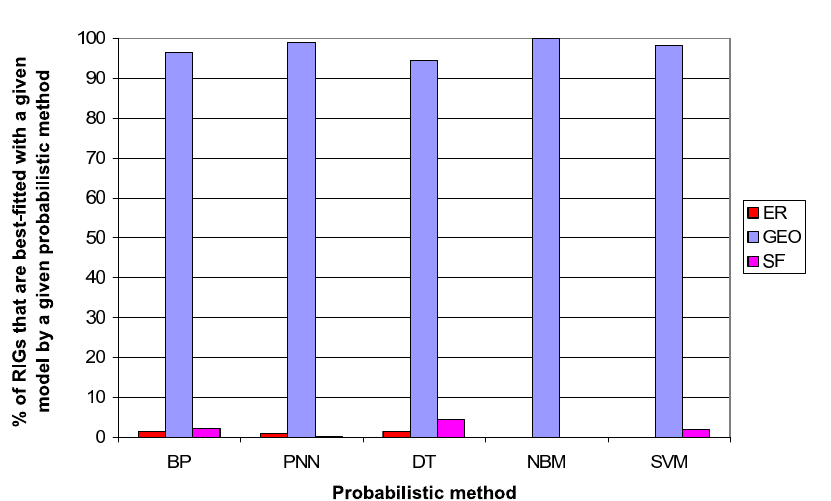
Figure S3: The best-fitting network model out of the three models (ER, GEO, and SF) predicted by the five classifiers (BP, PNN, DT, NBM, and SVM) for the 513 analyzed